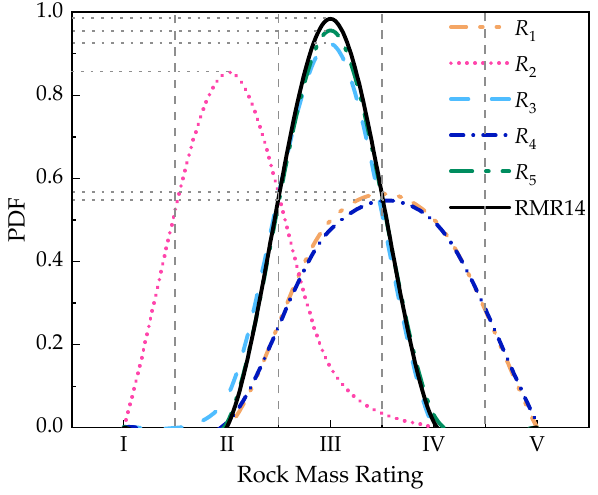
Figure 14. Fusion result of the initial data fusion in each index and final data fusion in RMR14. The result of the initial fusion of each index for the rock mass rating is used to conduct further data fusion. The total RBM of all the rock mass indices is calculated based on the results of initial data fusion by Equation (29). The further fusion process in Table 5 indicates that the rock mass rating of the K78+350 section is in level III with the maximum probability of 0.9838, which agrees with geological survey report of the Daxiagu tunnel.